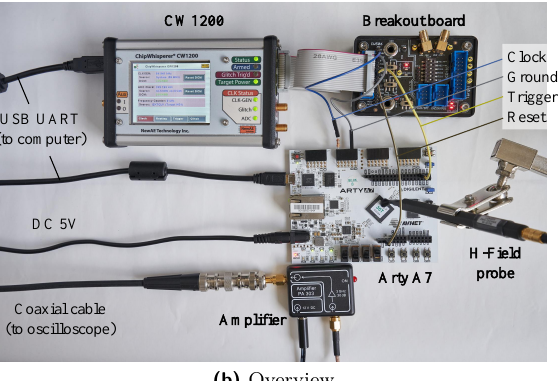
timing should be identified because the trigger is not necessarily generated immediately before the target